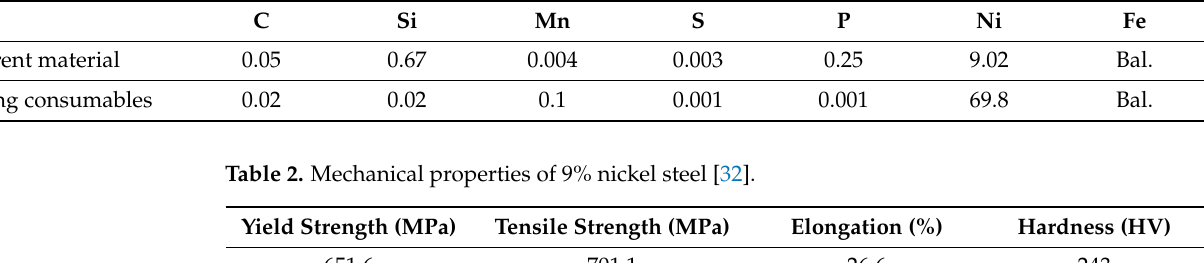
Table 1. Chemical composition of base metal and filler wire (wt. %) [32].